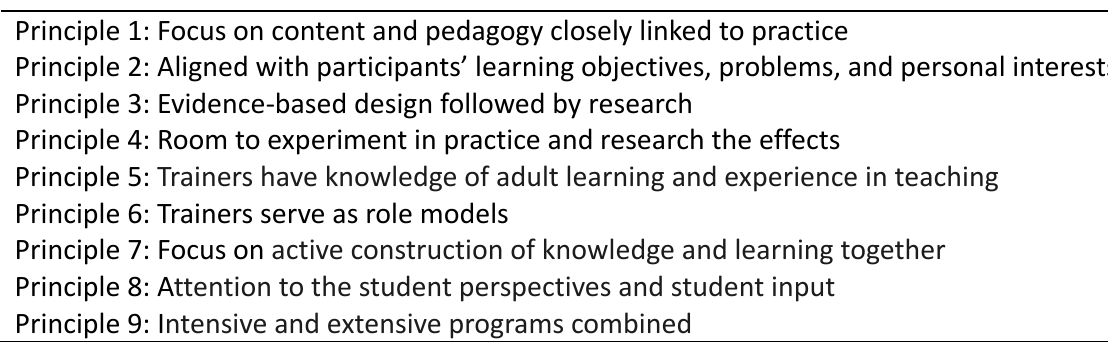
Table 1. Design principles for professionalization activities, based on